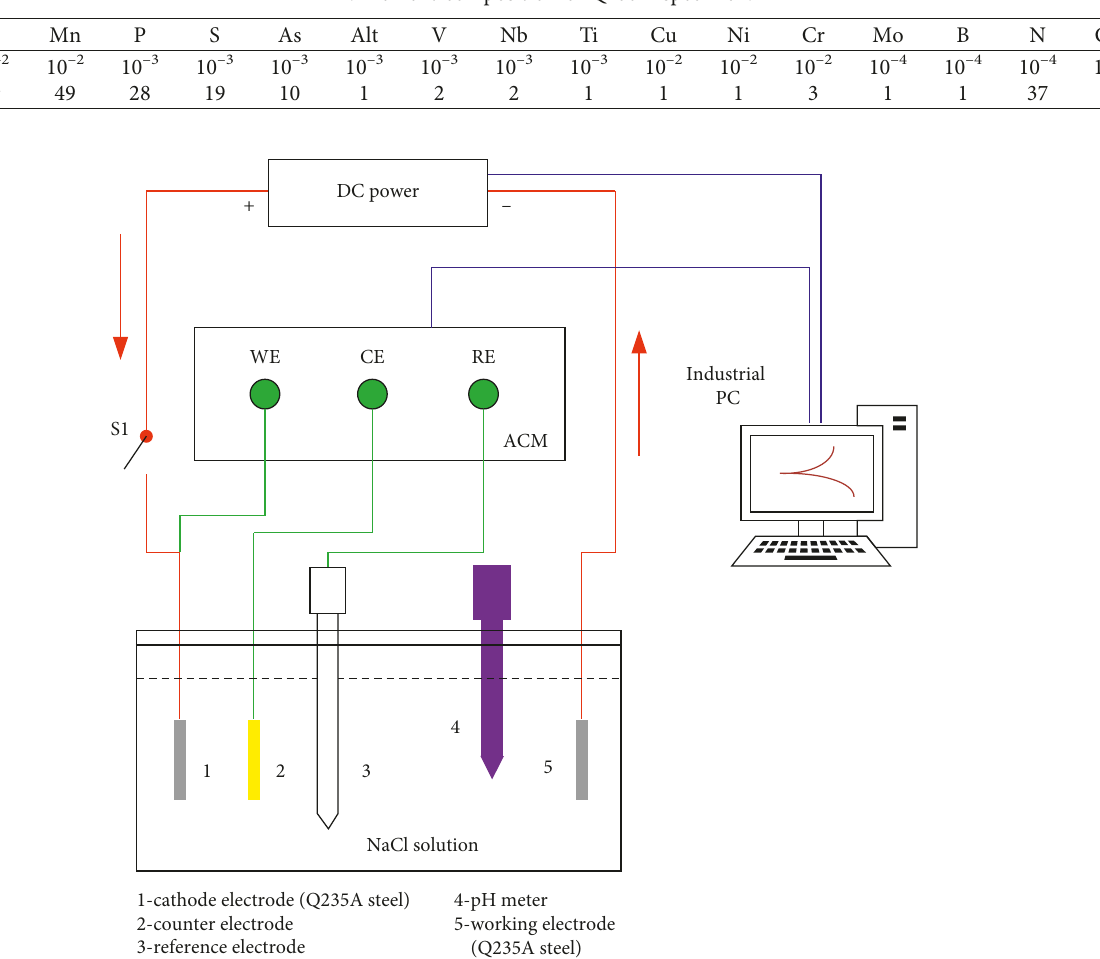
Figure 2: Experimental system of electrochemical corrosion under the coupling excitation of stray current and Cl −